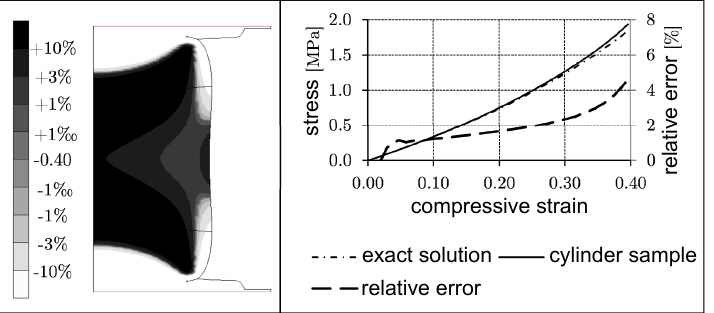
Figure 2. Inhomogeneous deformation in compression for a cylinder sample, FE-simulation with evaluation (figure from [12], labelling in English, p. 62).